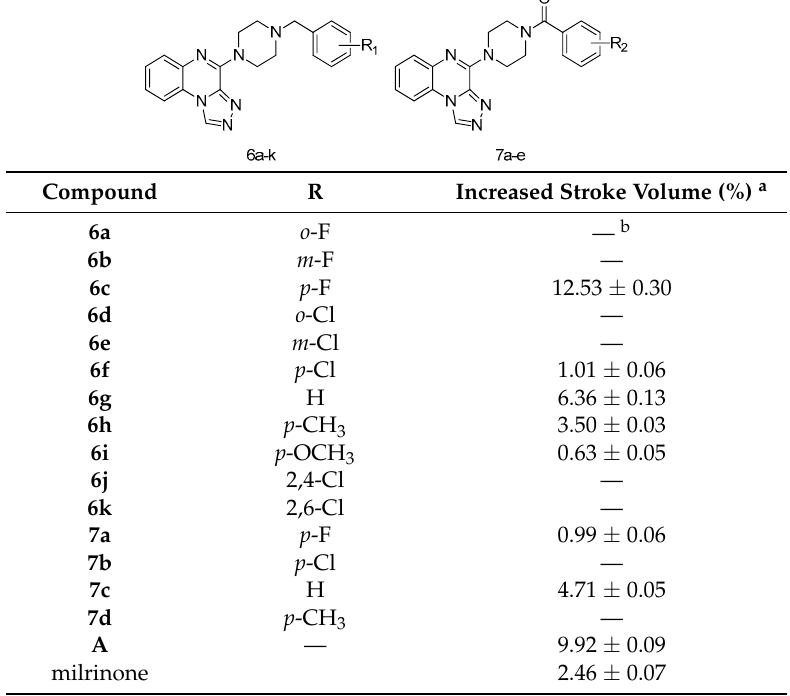
Figure 3. Concentration-response curves of compounds 6c and milrinone on stroke volume in beating rabbit atria (1.5 Hz). Values are means ± SE. *** p < 0.001 versus control.